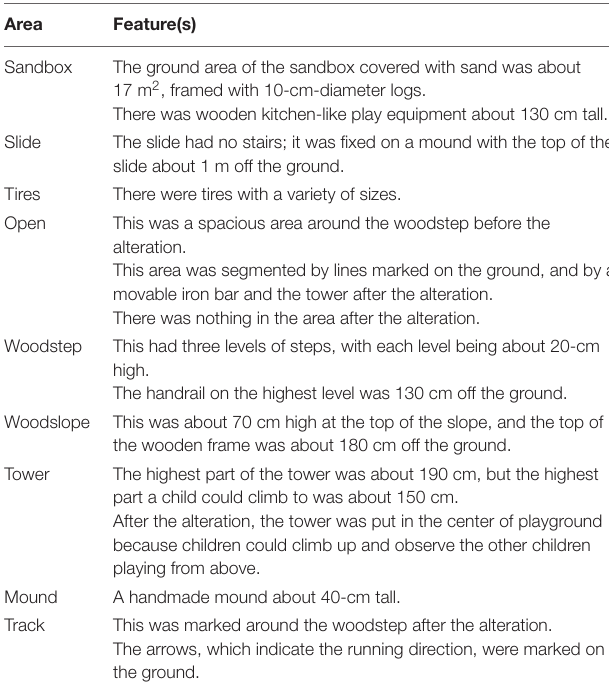
TABLE 1 | The detailed features of the play equipment and area. TABLE 2 | Children’s actions observed in play were coded into